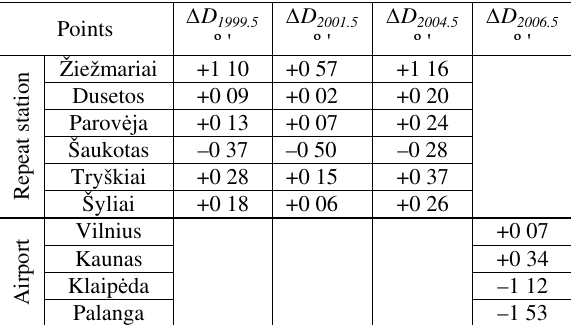
Table 2. Differences between declination values calculated from WMM and measured ones